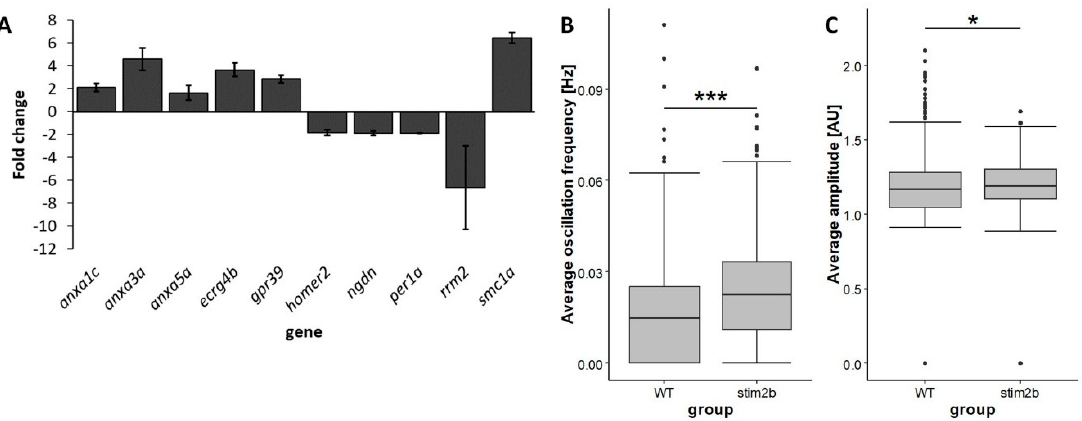
Figure 2. Di ff erential expression of genes that are related to the nervous system and increases in the frequency and amplitude of neuronal Ca 2 + oscillations in stim2b − / − larvae. ( A ) RNAseq results expressed as mean fold changes ± SD in stim2b − / − samples. The level of expression in WT was used as a reference value ( = 1). Number of samples: 4. Number of experiments: 2. The exact fold change values and statistics are presented in Table 3. ( B , C ) Box plots of the average frequency (Hz) ( B ) and average amplitude (AU) ( c ) of Ca 2 + signal oscillations in neurons in the periventricular gray zone of the optic tectum. * p < 0.05, ** p < 0.01, *** p < 0.001, mutant vs. WT (Wilcoxon rank-sum test). Number of cells: 456 (WT) and 336 ( stim2b − / − ). Number of animals: n = 8 WT, n = 6 stim2b − / − . Table 3. RNAseq results of the differential expression of genes that are related to the nervous system in stim2b − / − larvae. Student’s t -test was used to compare FPKM-normalized expression values between mutant and WT, and the p values were corrected for multiple testing. * p < 0.05 (FDR < 0.05), ** p < 0.01 (FDR < 0.05), significant difference in fold changes. Number of samples: 4. Number of experiments: 2.